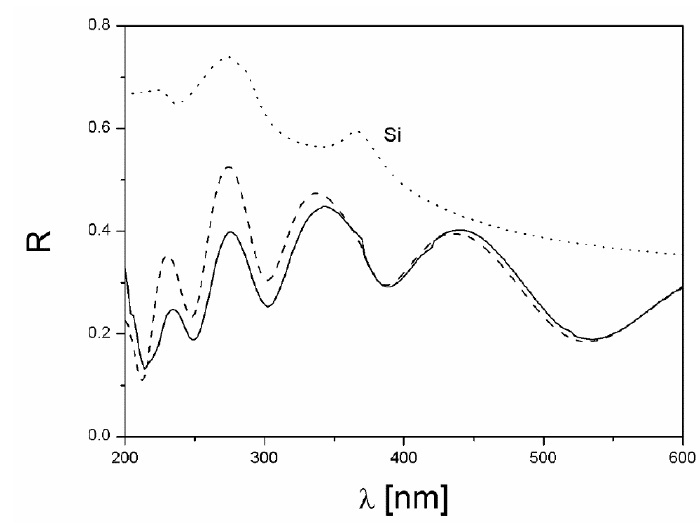
Figure 7. Total reflection from the porous SiO 2 film (sample P2, solid line) and reflectance at normal incidence (dashed line) calculated from the ellipsometric study.